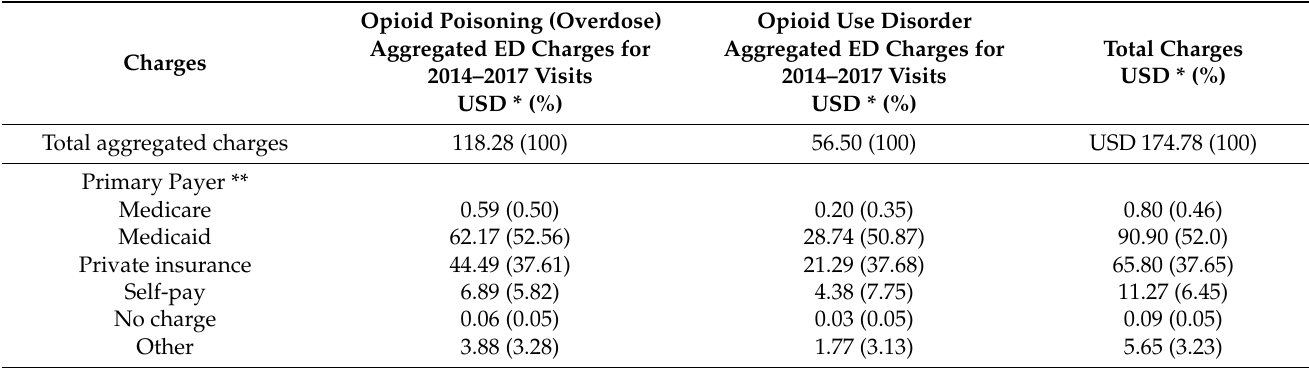
Table 3. Aggregated charges billed for services by primary payer during visits to emergency de- partment of children with diagnoses codes related to overdose and OUD, 2014–2017. Source NEDS 2014–2017 weighted